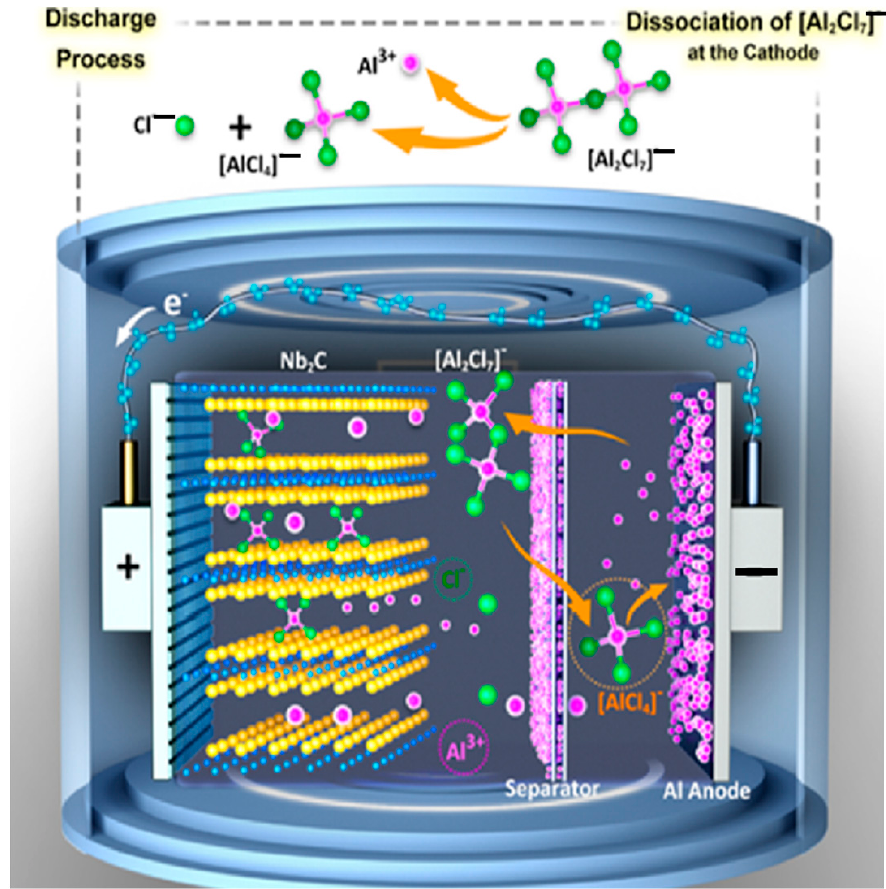
Figure 7. Nb 2 CT x MXene-based Al battery concept is described schematically. Reprinted with permission from 2022 American Chemical Society